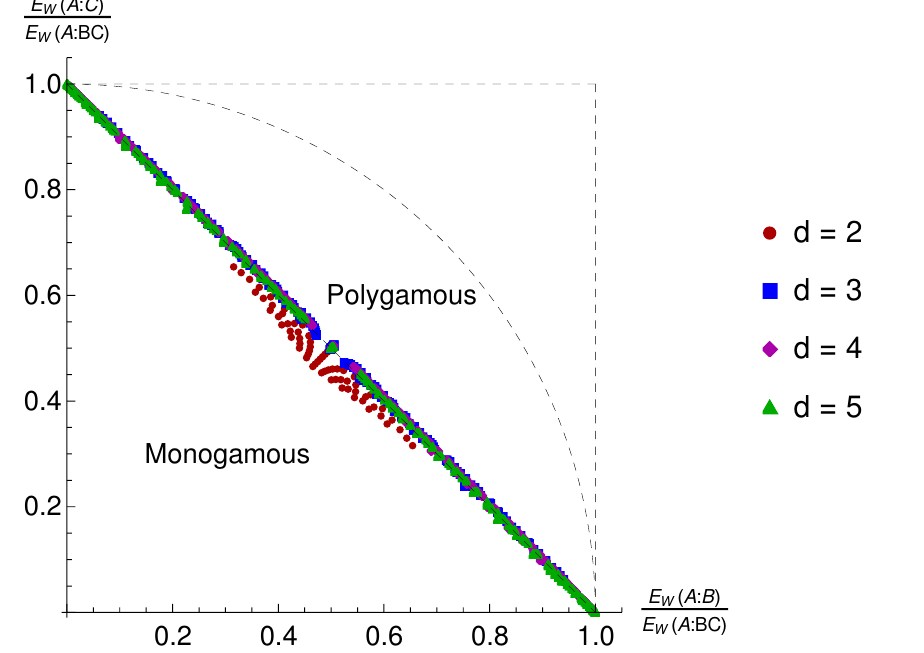
Figure 10 . The ratio of the wedges E W ( A : B ) /E W ( A : BC ) and E W ( A : C ) /E W ( A : BC ) in the S B phase for the pure AdS d +1 geometries for various separations s 1 and s 2 of the